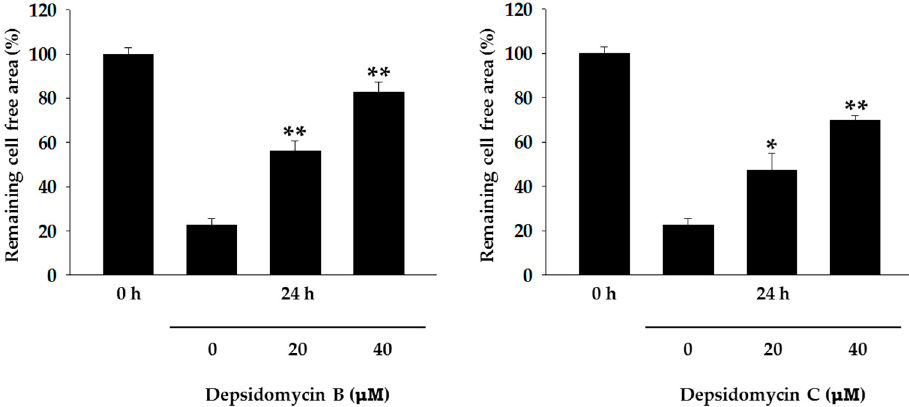
Figure 4. Remaining cell-free area (%) of MDA-MB-231 cells treated with depsidomycin B ( 1 ) and C ( 2 ). All data are expressed as the means ± SD ( n = 3). * p < 0.05. ** p < 0.01 compared to the control.